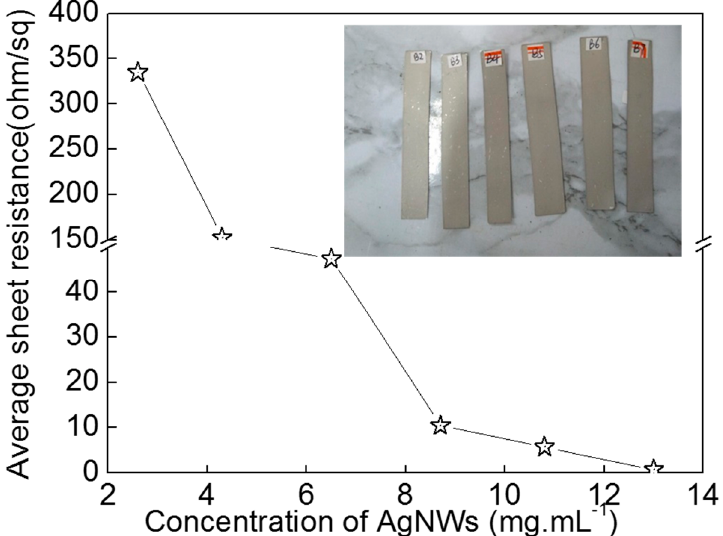
Figure 8. Relationship between average sheet resistance of AgNWs coating and the concentration of AgNWs ink. The inserted image is a photo of the samples.